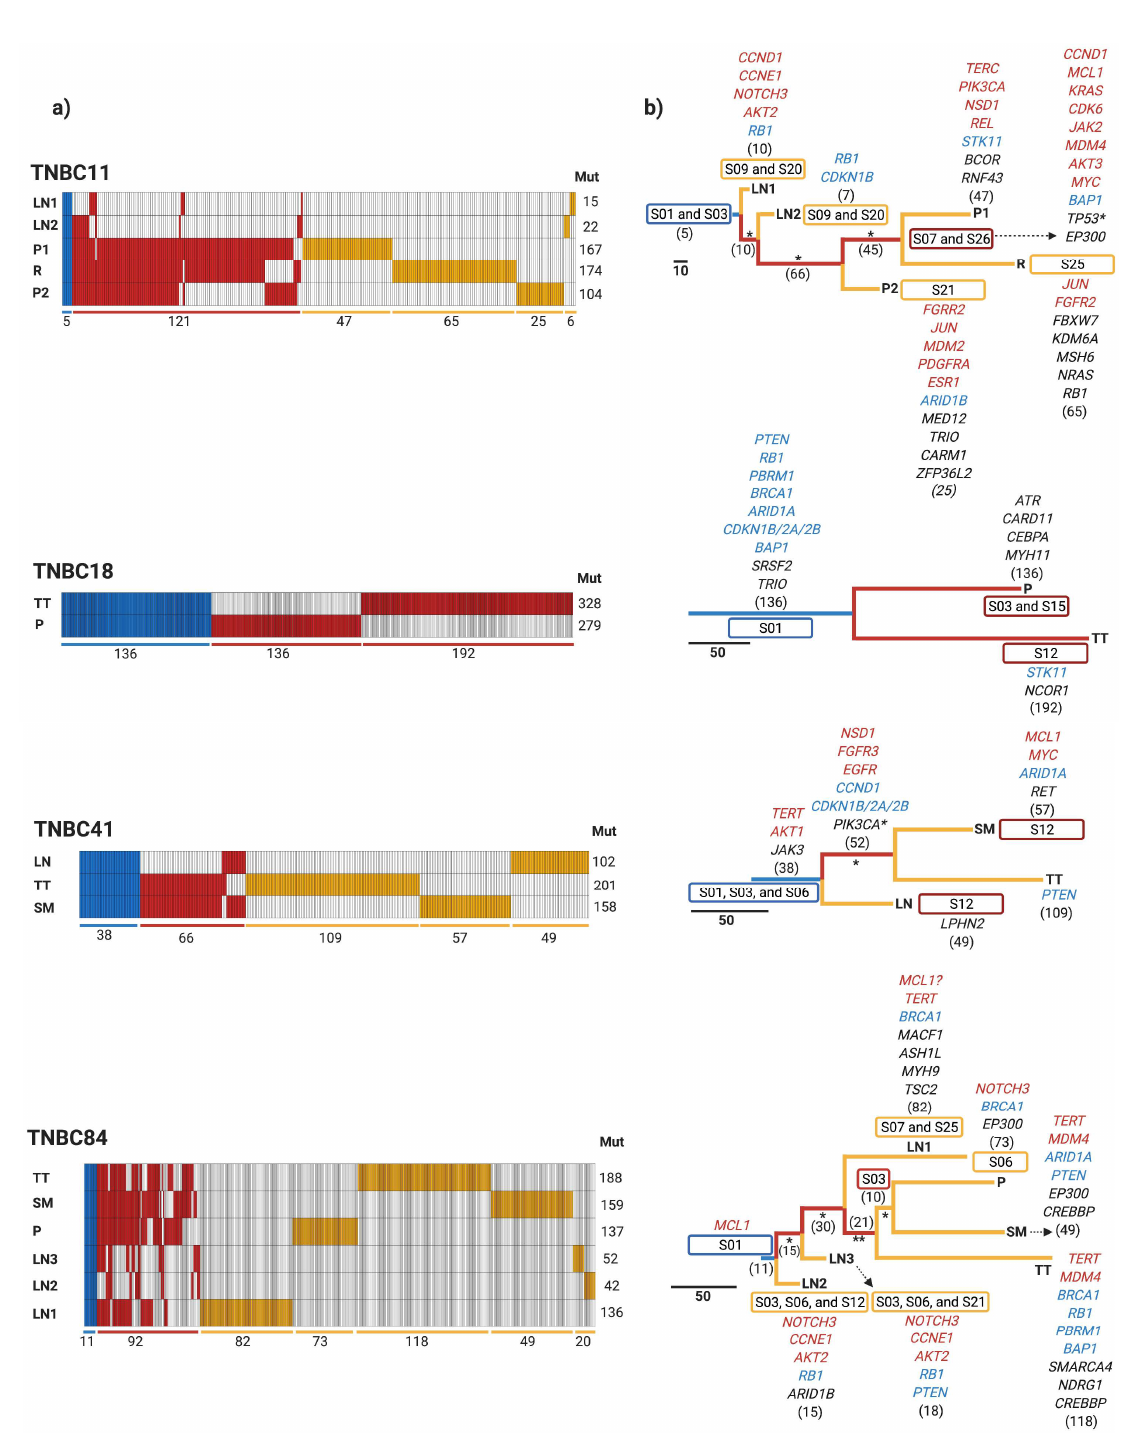
Figure 4. Phylogenetic trees of TNBC patients. ( a ) Heatmap depicts truncal (blue), shared (red), and private (yel- low) mutations found in each sample. The number of mutations is shown at the bottom, and the total mutations for each sample are placed on the right. ( b ) Phylogenetic trees depict the relationship of samples from each patient. The length of the branches is proportional to the number of detected mutations. Driver genes such as SNV (black), am- plifications (red), and deletions (blue), as well as mutational signatures found, are shown for each sample in this co- hort. P: primary treatment-naïve tumor; TT: treated tumor; R: recurrence; LN: lymph node; and SM: skin metastasis. * = bootstrap value >95%, and ** = bootstrap value >65% and